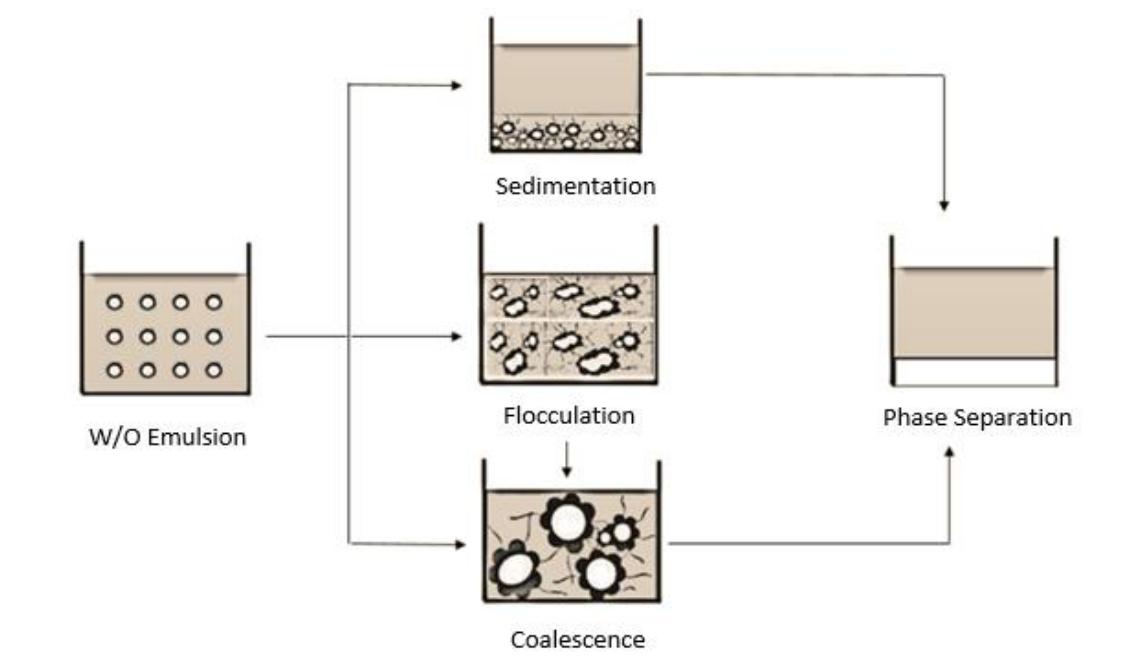
Figure 4. The sequence of the breakdown process in (W/O ) emulsions [7].